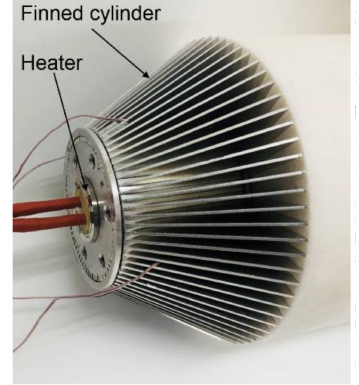
Figure 2. Photograph of finned cylinder.